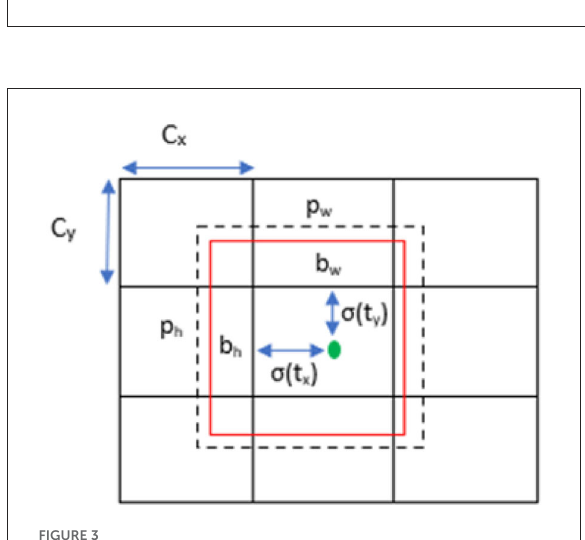
FIGURE3 Bounding box prediction with